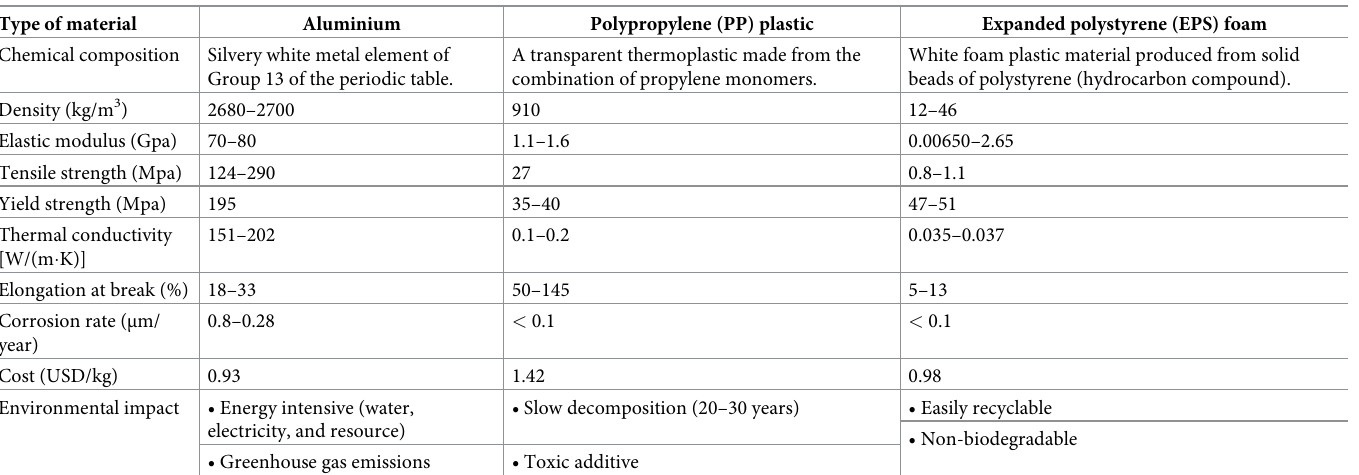
Table 1. Characteristics of the materials used for drone flights F1, F2 and